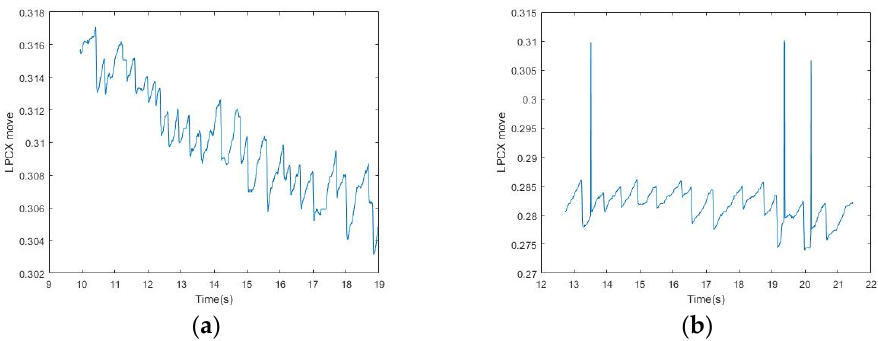
Figure 11. ( a ) Inability to focus on the same level and excessive drop from the starting position because of eye fatigue; ( b ) involuntary eye drift and signals of excessive displacement.